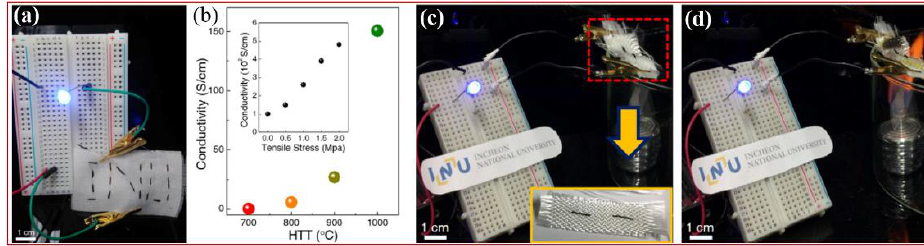
Figure 7. ( a ) Conducting behavior of commercial silk yarn. ( b ) HTT-dependent conductivity. ( c , d ) Thermal durability of the e-textile. Reprinted with permission from Reference [47]. Copyright (2018) Elsevier.